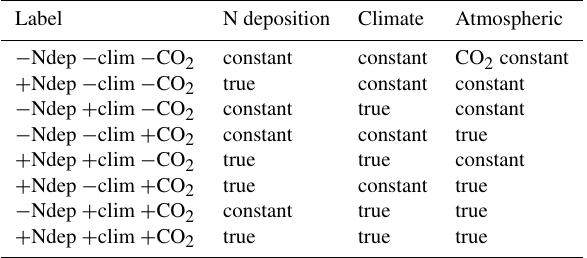
Table 1. Simulation runs in the factorial simulation experiment. Note that climate comprises four variables (Sect.